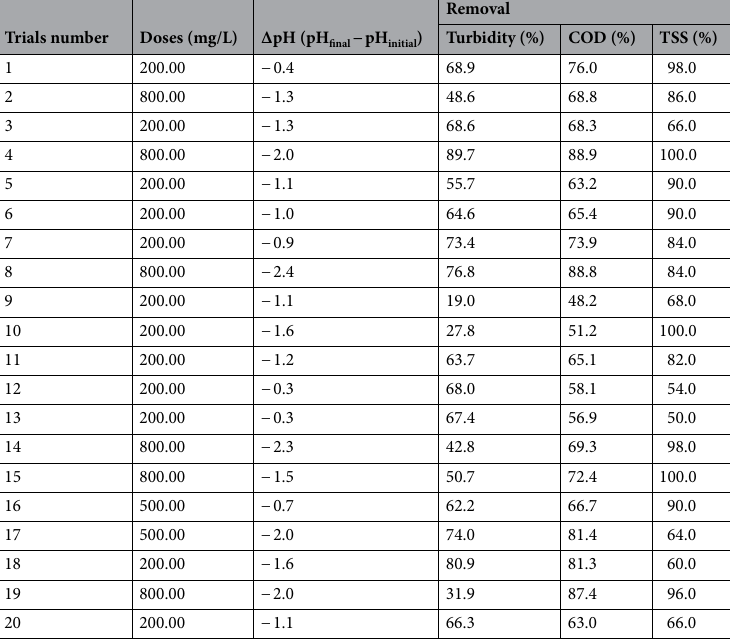
Water quality parameter Model significance ( p value) Lack of fit significance ( p value) Equations